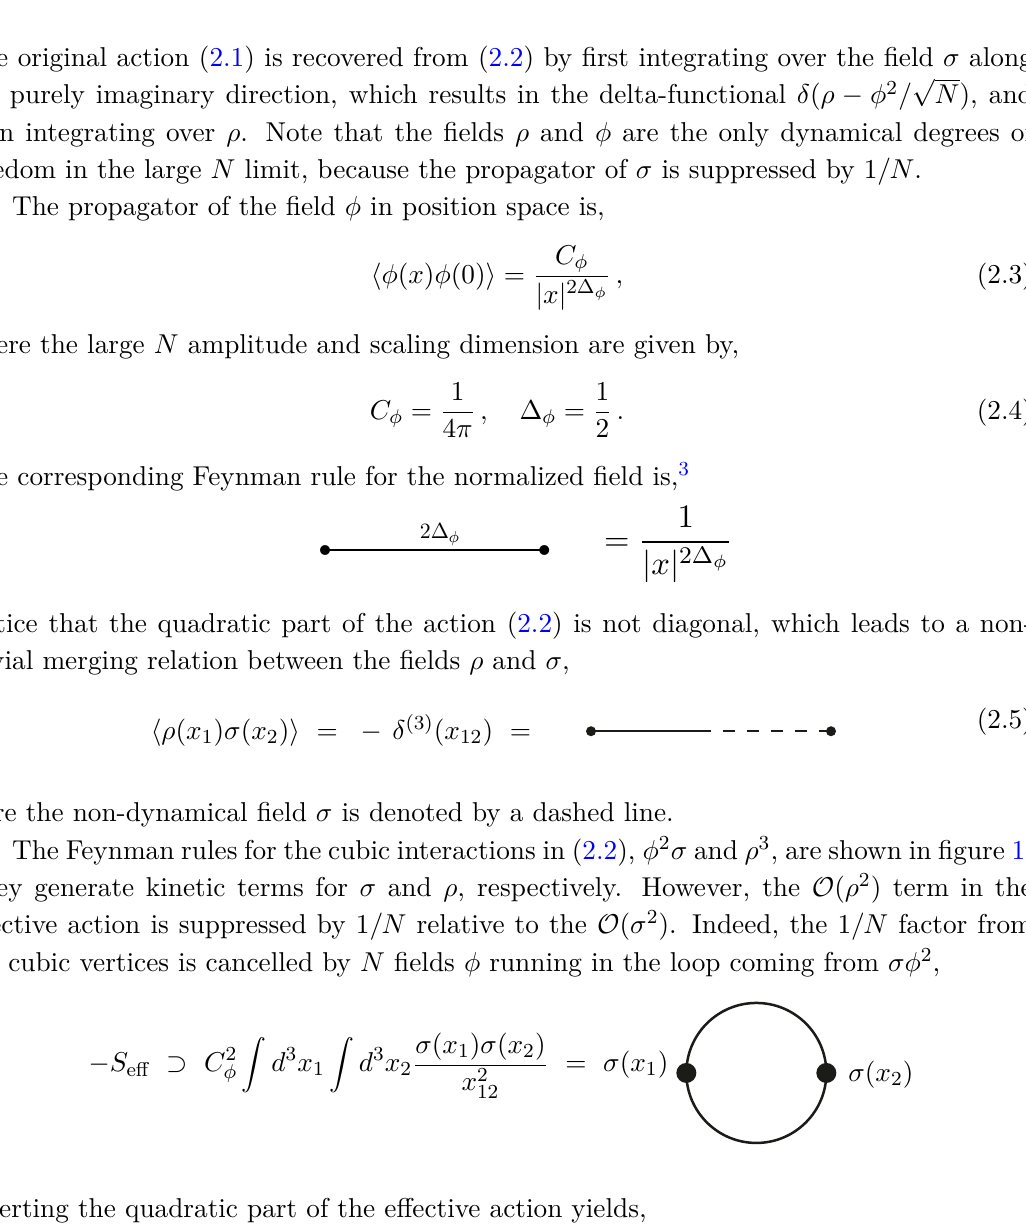
Figure 1 . Feynman rules for the cubic interactions in